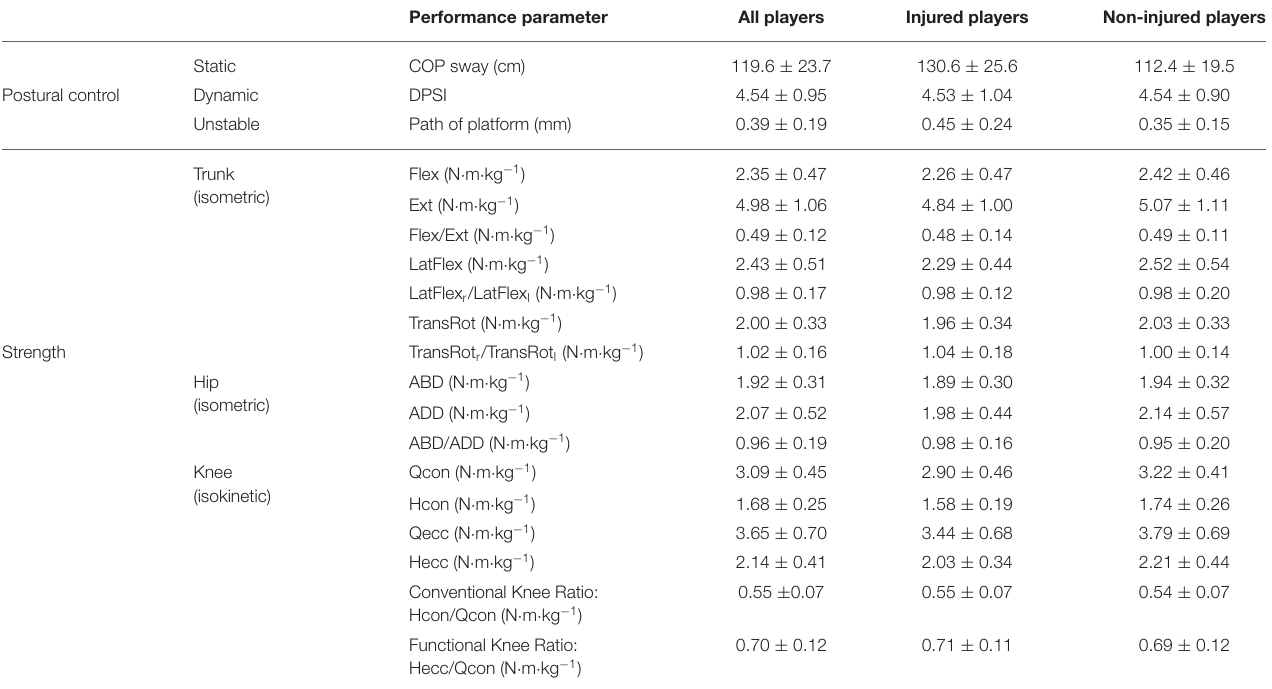
TABLE 1 | Descriptive statistics (mean ± standard deviation) of all players investigated according to their injury state